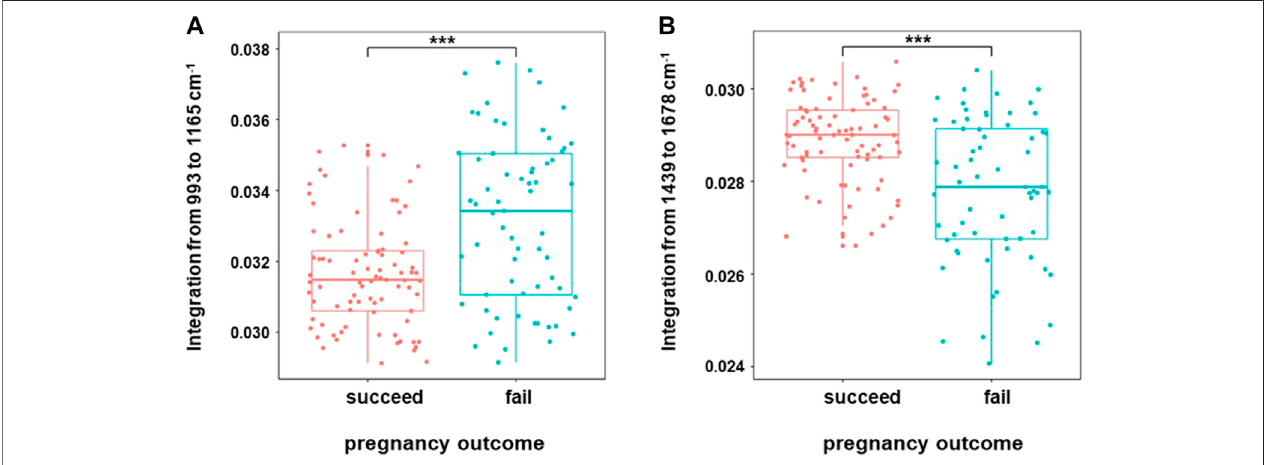
FIGURE 7 | Boxplots of Raman band integration of successful pregnancy group and failed pregnancy group in PCOS. The signi fi cant differences at 993 – 1,165 cm − 1 (A) and 1,439 – 1,678 cm − 1 (B) were shown between the two groups in PCOS. The rectangle in the box plots represents the second and the third quartiles, with the line inside representing the median. The lower and upper quartiles are drawn as lines outside the box. Sample means were compared by Welch 2- sample t test for unequal variances. *** indicates p < 0.001.